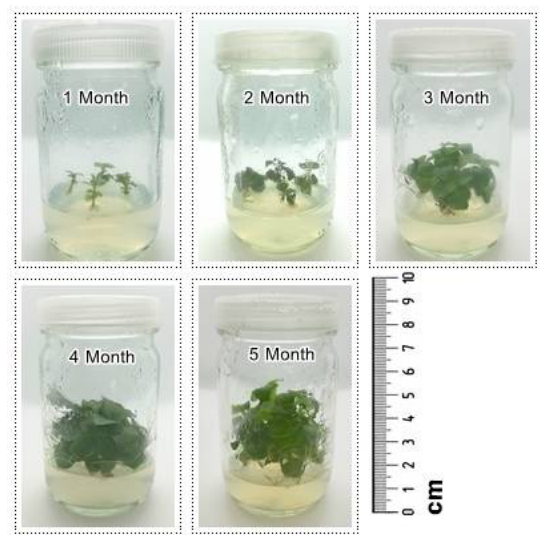
Figure 1. Tissue culture plants of O. ridleyana in half strength MS medium after cultivation for 1–5 months.